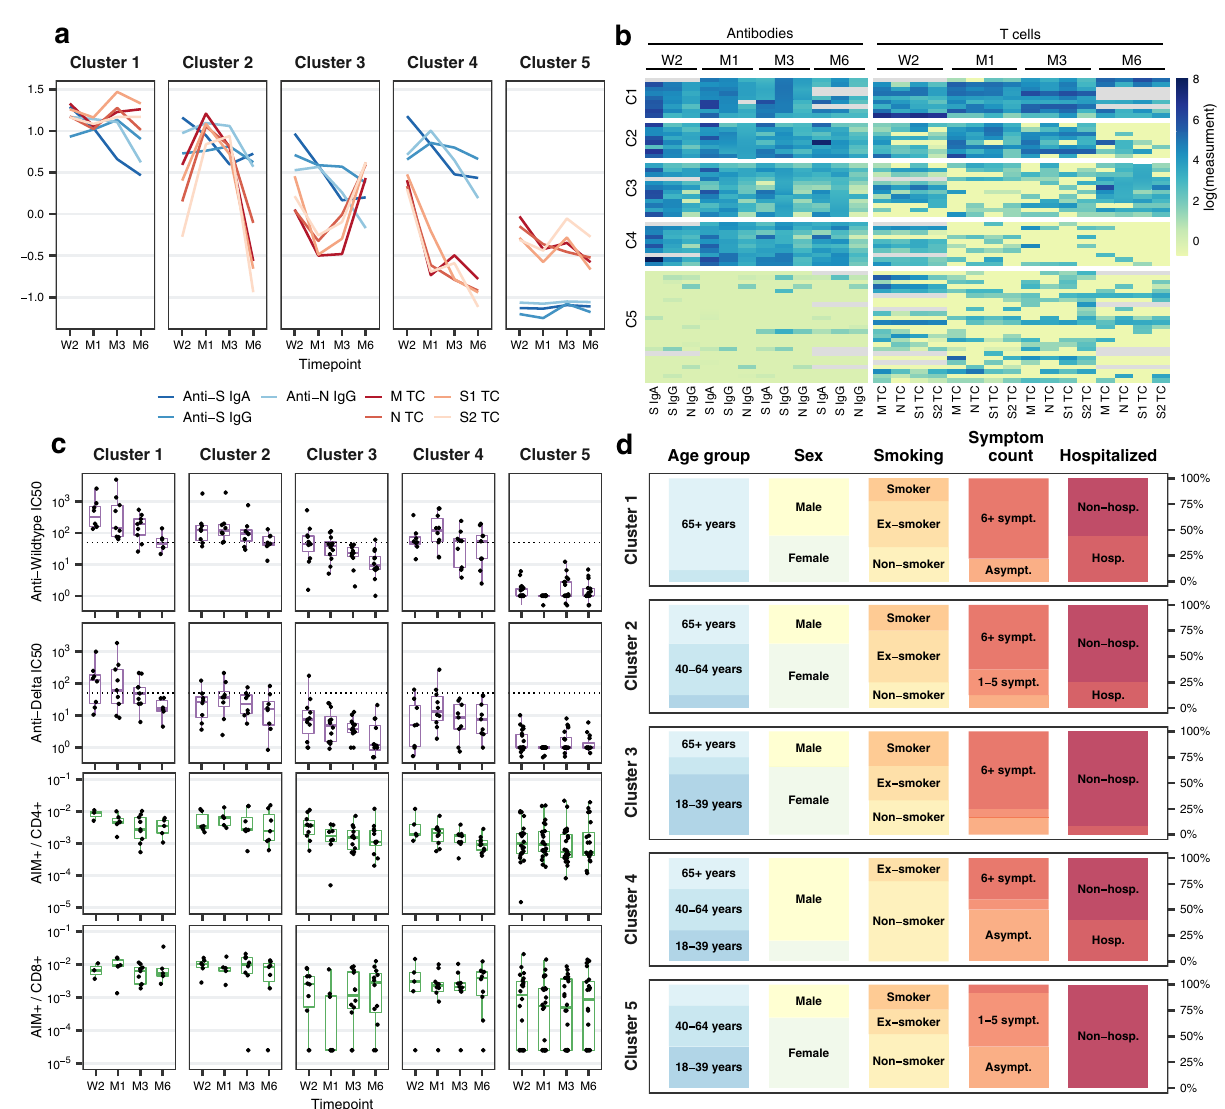
Fig. 6 | Clustering of antibody and T cell response trajectories. a Average mean fl uorescenceintensity(MFI)ratiosofanti-SIgA,anti-SIgG,andanti-NIgGantibodies andmeanM,N,S1,andS2epitopepool-speci fi cTcells(spot-formingunits(SFU)per 1e6 peripheral blood mononuclear cells (PBMCs)) in each of the fi ve clusters over time (total n =64; cluster 1: n =9, cluster 2: n =8, cluster 3: n =12, cluster 4: n =10, cluster5: n =25).Displayeddatawasnaturallogarithm-transformedandnormalized (rescaled). W2: two weeks, M1: one month, M3: three months, M6: six months after diagnosis. b Heatmap showing anti-S IgA, anti-S IgG, and anti-N IgG MFI ratios and M,N,S1,andS2epitopepool-speci fi cSFU/1e6PBMCsforallparticipantsbelonging to the fi ve identi fi ed clusters. Gray color indicates missing values, displayed data corresponds to natural logarithm-transformed measured data. C1 – 5: cluster 1 to 5.